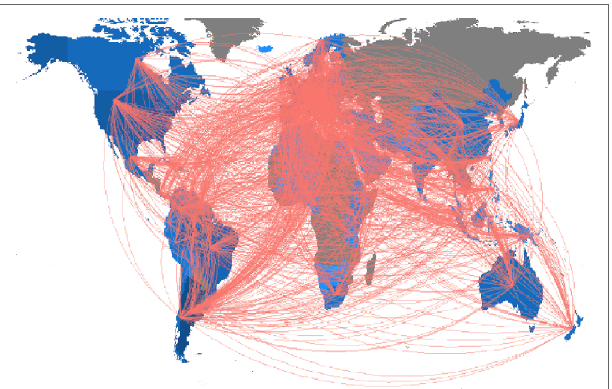
FIGURE 6 | Collaboration map between Argentina and the rest of the world, based on herbaria-based-research articles published from 1993 to 2018, based on the bibliometric analysis of publications stored at Scopus (refer to the text to see filters of the search).